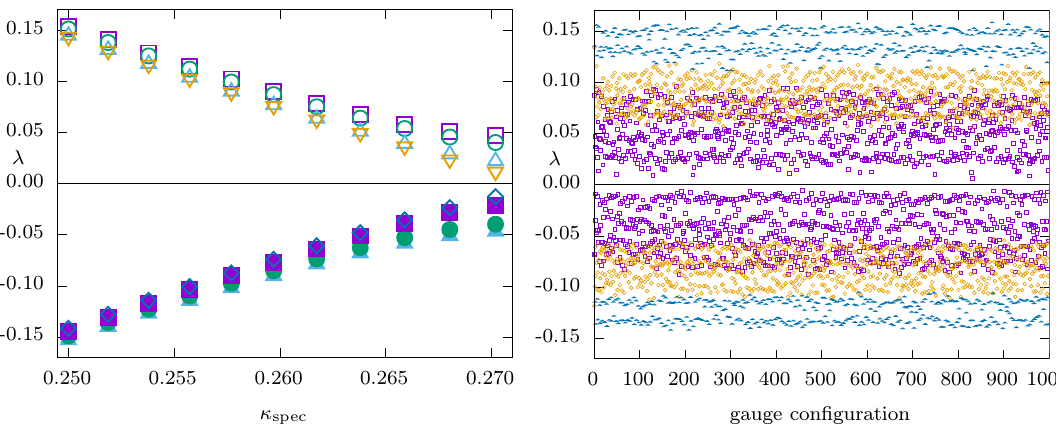
Figure 1. Left: spectral (cid:13)ow of 8 eigenvalues with smallest absolute values for (cid:12) = 15 : 5, (cid:20) = 0 : 27020 on a 64 (cid:2) 32 lattice. Right: smallest eigenvalues for three di(cid:11)erent values of the spectral (cid:13)ow parameter (cid:20) spec : 0 : 25379 (blue triangles), 0 : 26174 (orange circles) and (cid:20) (purple